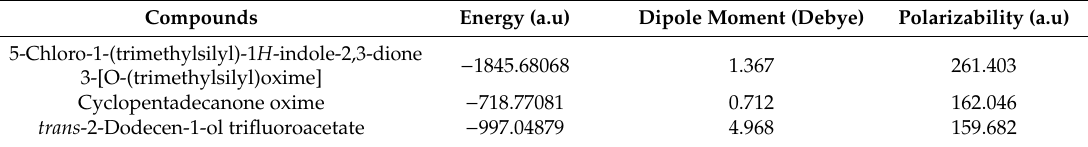
Table 2. Optimizedenergiesof5-chloro-1-(trimethylsilyl)-1 H -indole-2,3-dione3-[O-(trimethylsilyl)-oxime]; cyclopentadecanoneoximeand trans -2-dodecen-1-oltrifluoroacetatewithdipolemomentandpolarizability. Compounds Energy